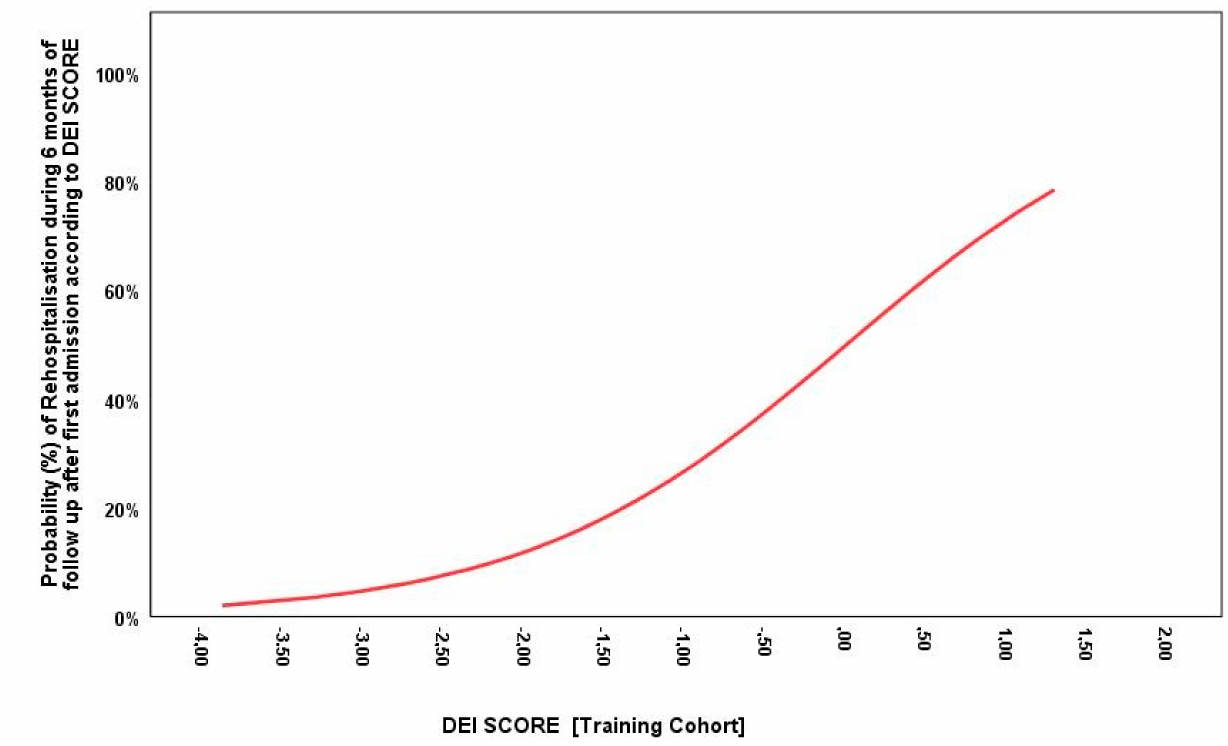
Figure A3. Probability plot of the HFR during 6 months of follow up after the first admission according to the DEI